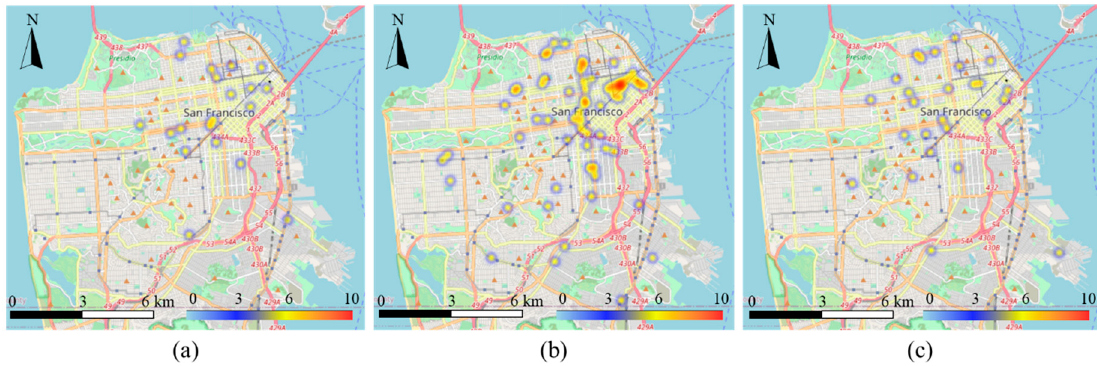
ISPRS Int. J. Geo-Inf. 2020 , 9 , x; doi: FOR PEER REVIEW Figure 9. Hotspots of burglary in Chicago, IL ( a ) 24 May 2020; ( b ) 31 May 2020; ( c ) 7 June 2020.